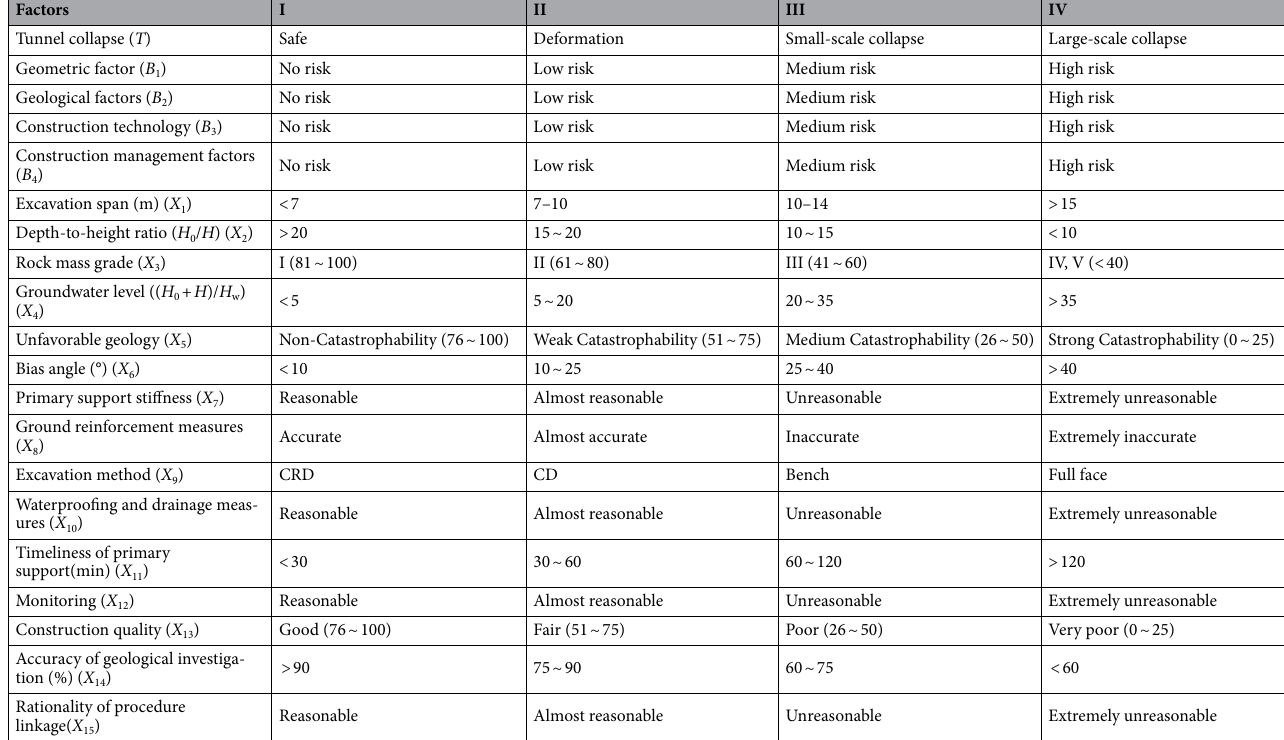
Table 1. Classified states of tunnel collapse risk